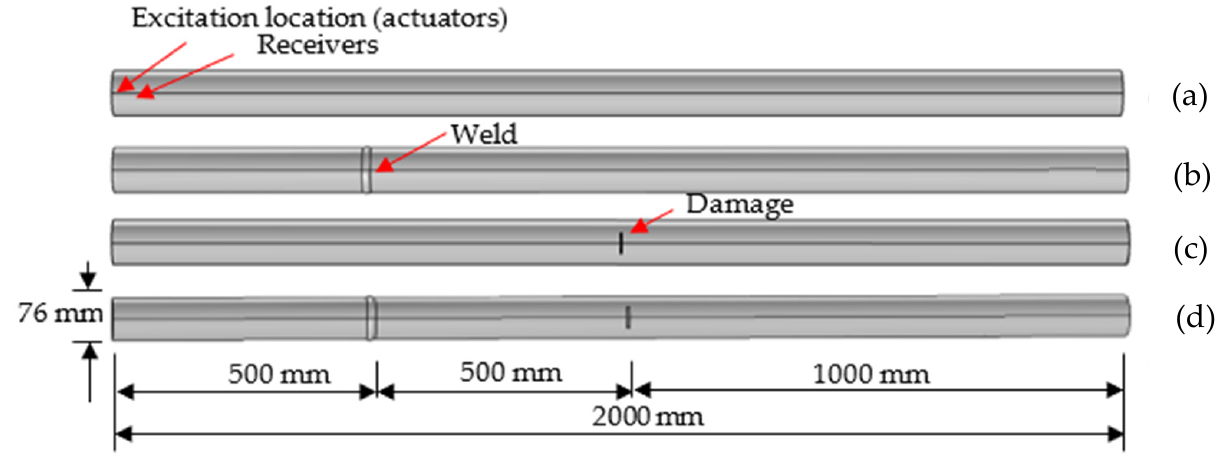
Figure 6. COMSOL models of pipes in different states: ( a ) intact pipe; ( b ) pipe with a weld; ( c ) pipe with a crack; ( d ) pipe with crack and